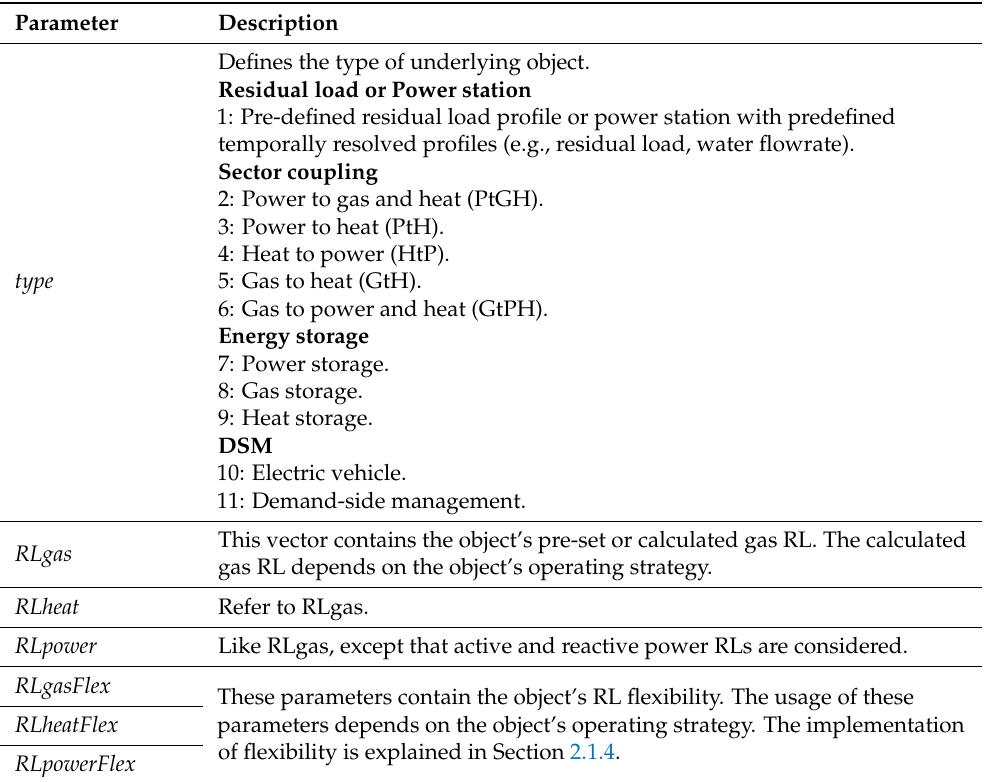
Table 2. Overview of RL class